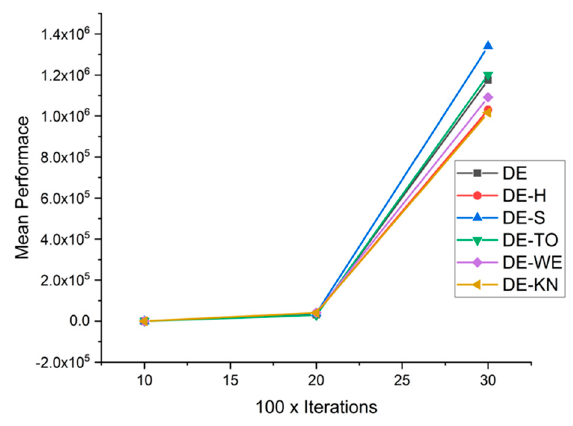
Figure 33. Convergence curve on fn11.